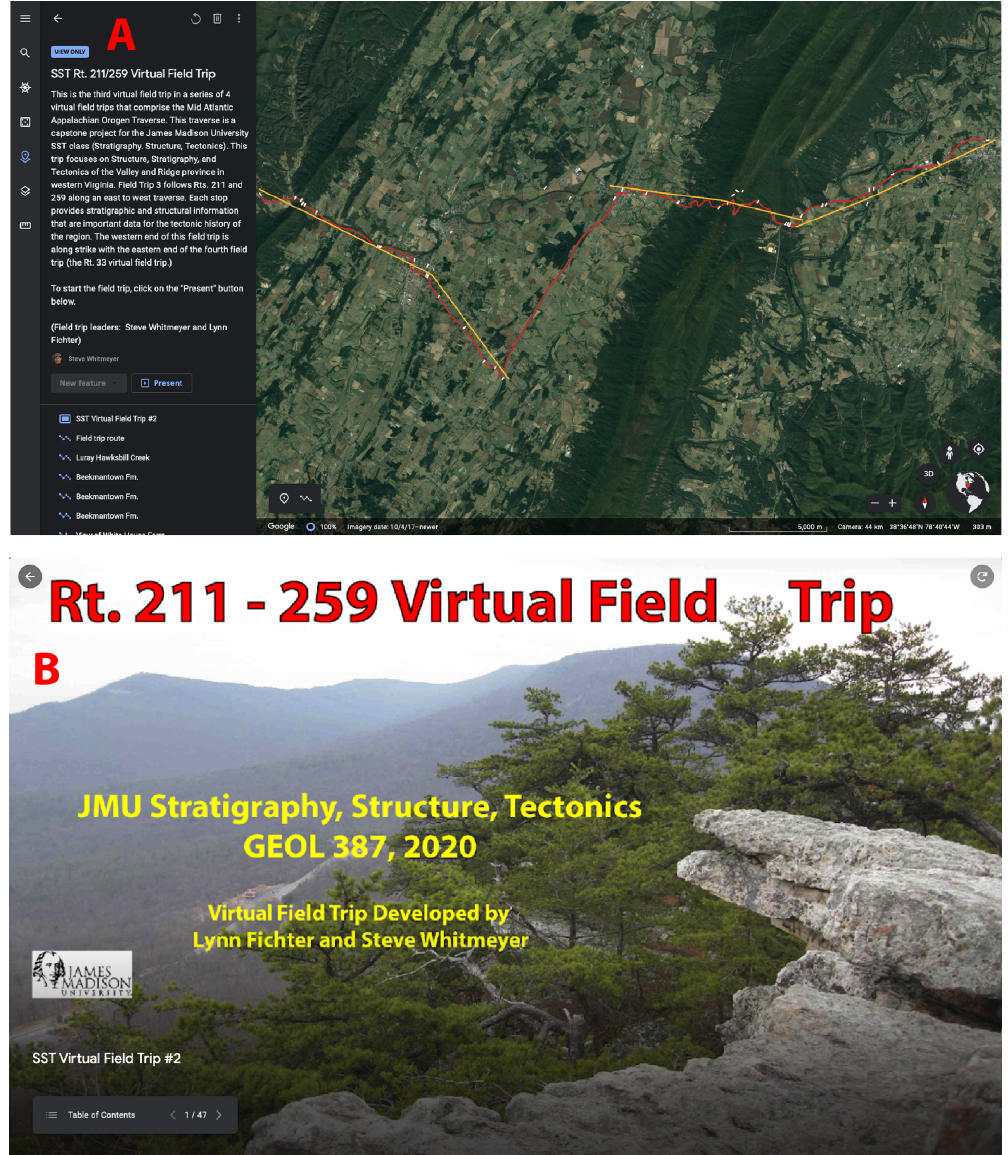
Figure 2. Screen images of web-based © Google Earth virtual field trip 3 from the Mid Atlantic Appalachian Orogen Traverse project; (a) overview of the SST Rt. 211/259 Virtual Field Trip project in © Google Earth; (b) title slide for the Rt. 211–259 Virtual Field Trip in © Google